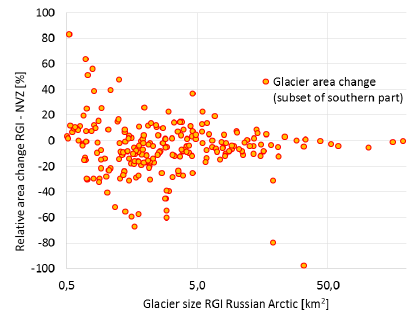
Figure 9. Relative change in glacier area from ~2001 to 2016 vs. glacier size in 2001.